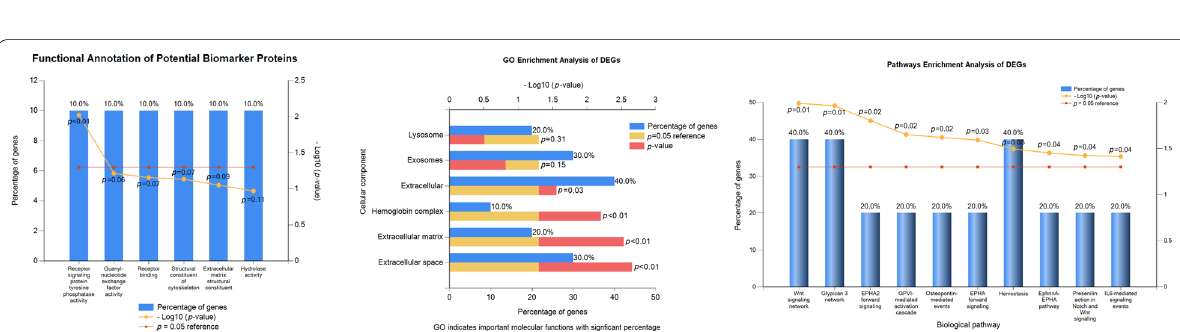
Fig. 5 The functional annotation and GO analysis indicate important molecular functions of selected biomarker proteins using FunRich and DAVID annotation